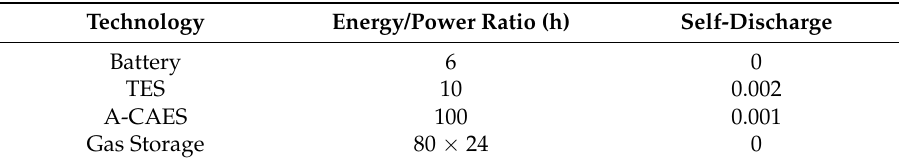
Table A3. Energy to power ratio of the storage technologies.